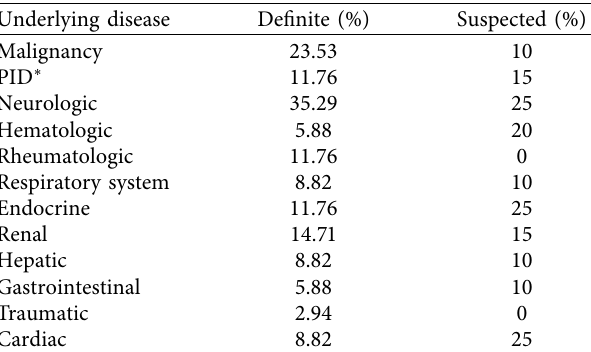
Table 3: Types of underlying diseases in the definite/suspected